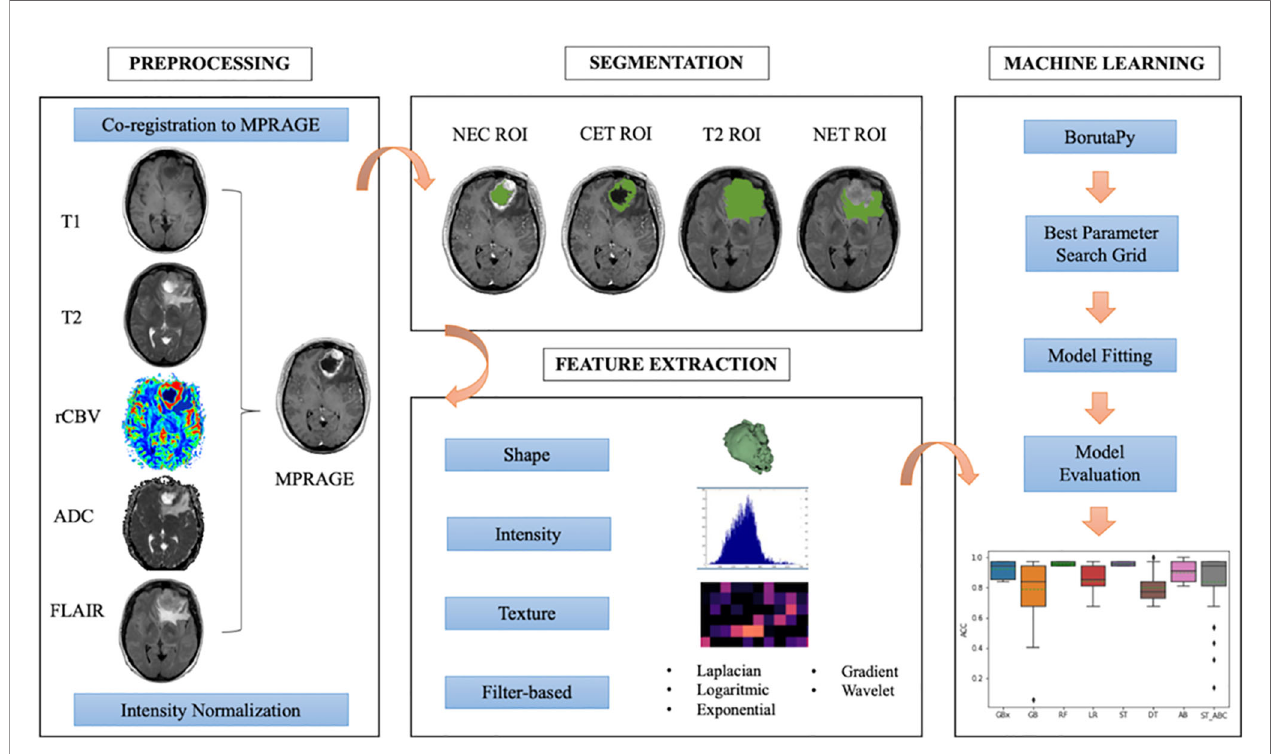
FIGURE 1 | Radiomic work fl ow followed in the present